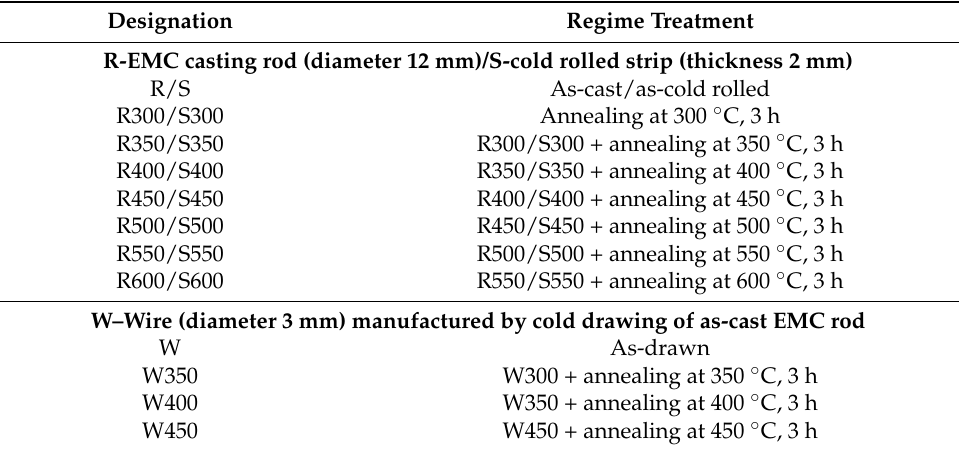
Table 2. Annealing regimes for electromagnetic casting (EMC) rod, strip and